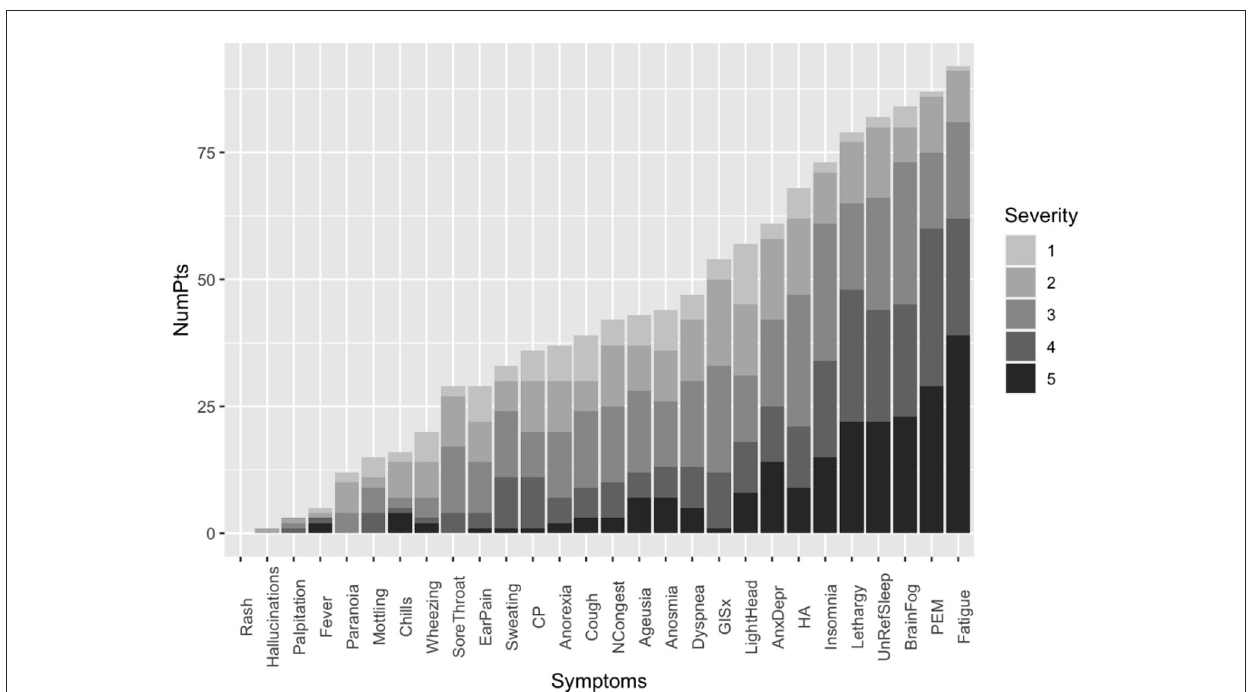
FIGURE2 Distribution of the frequency and severity of the symptoms on the PASC clinic intake questionnaire for subgroup of 105 patients with persistent symptoms for six or more months. Symptom severity was measured on the Likert scale with a severity score of 5 being the most severe. CP, Chest pain; GISx, Gastrointestinal symptoms; Anex/Depr, Anxiety/Depression; HA, Headache; UnRefreSleep, Unrefreshed sleep; PEM, Post-Exertional Malaise; NCongest, Nasal